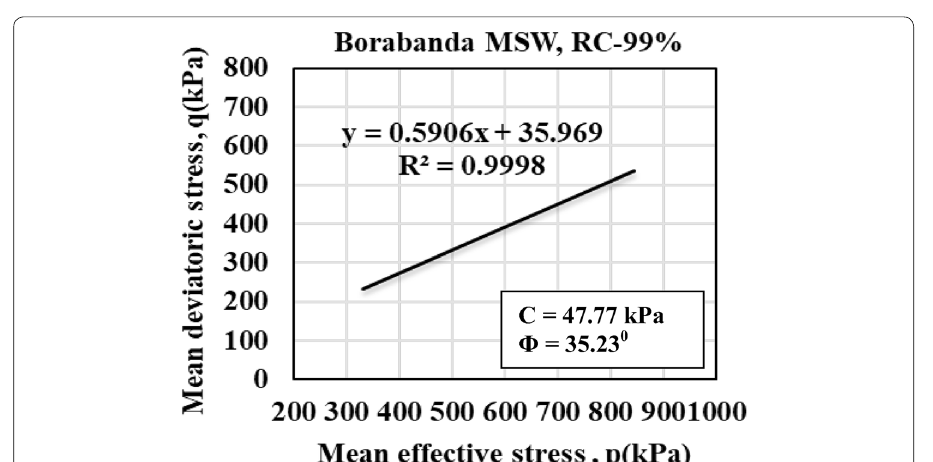
Fig. 34 p–q diagram of Borabanda MSW at